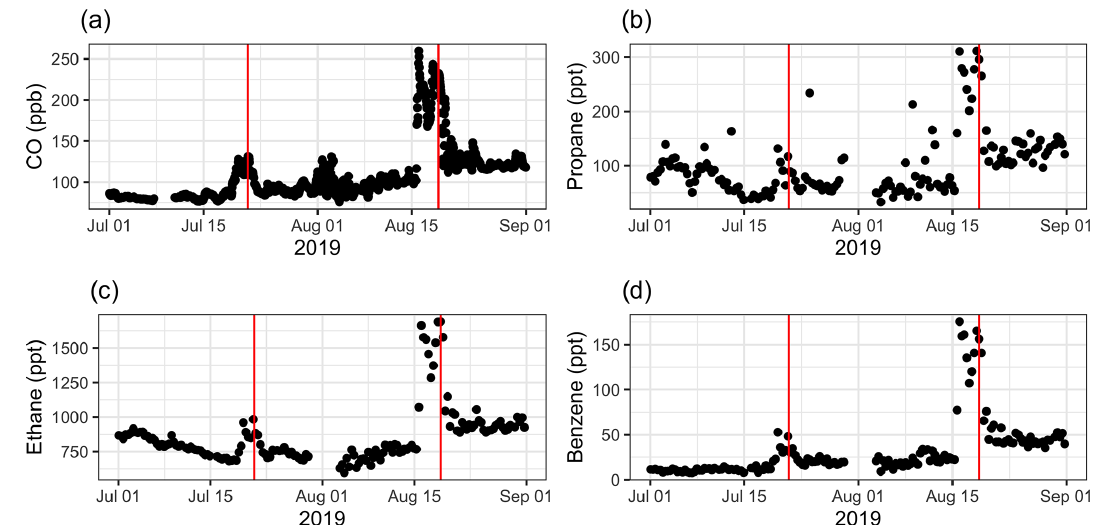
Figure 7. Time series of (a) carbon monoxide (CO), (b) propane, (c) ethane, and (d) benzene mixing ratios in ambient air at GEOSummit in July–August 2019. The two vertical red lines show the simultaneous enhancement of mixing ratios in two biomass burning plumes.